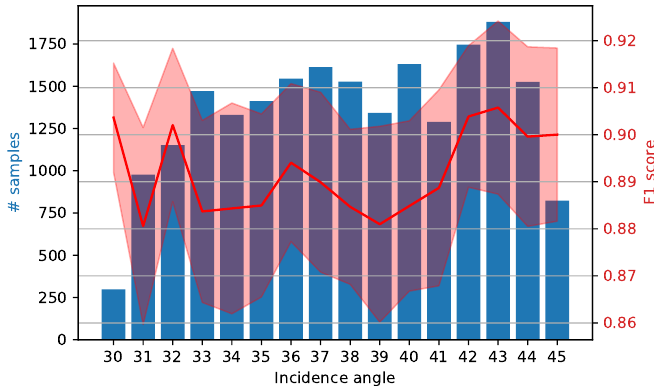
Figure 8. Variation of the F1 score on the validation set according to the incidence angle of the